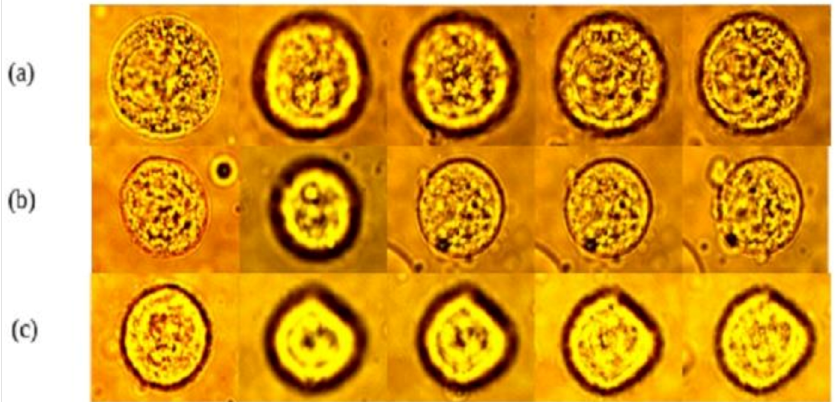
Figure 2. ( a ) A549 cell treated for 3 h at 2700 mW; ( b ) A549 cell treated for 6 h at 2700 mW; ( c ) untreated cell at 2700